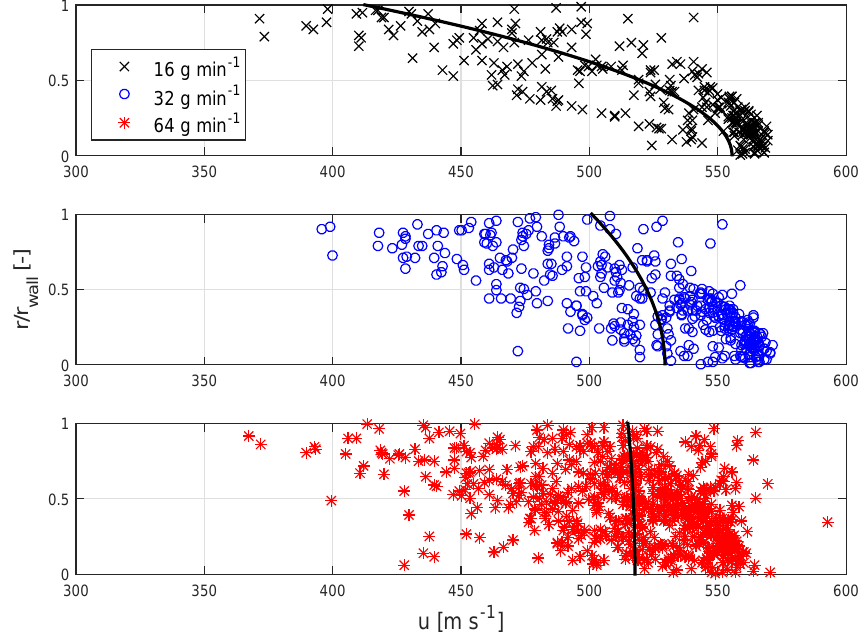
Figure 13. Comparison of titanium particle velocity profiles along radial position at the nozzle exit (coupled)